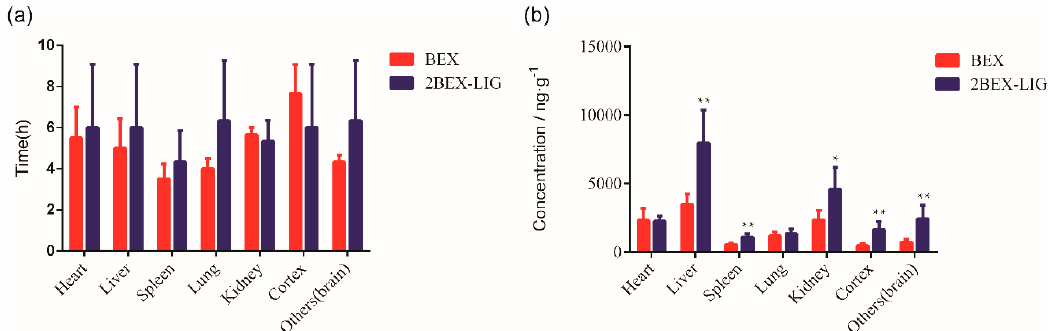
Figure 10. Tissues distribution parameters of bexarotene (BEX) in SD rats orally administrated with BEX (30 mg/kg) and 2bexarotene-ligustrazine (2BEX-LIG) (equivalent to 30 mg/kg BEX): ( a ) the peak time of maximum concentration in tissues and ( b ) the maximum concentration of BEX in tissues. ( n = 6). * p < 0.05, ** p < 0.01 vs. BEX.